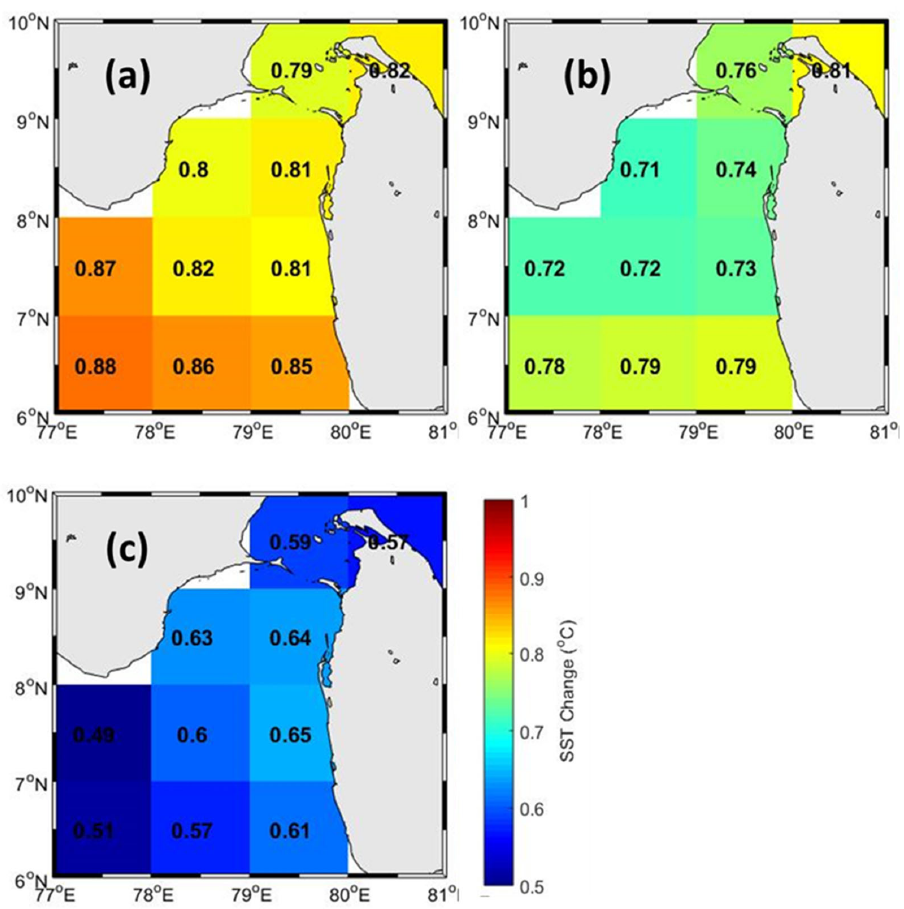
Figure 10. Spatial changes in SSTs in the GoM from ( a ) 1870–2018, ( b ) 1920–2018, and ( c ) 1970–2018.